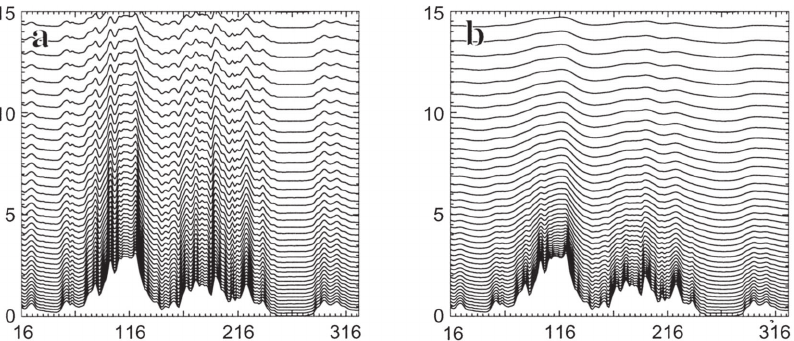
Figure 12. Vertical sections showing terrain-following vertical coordinates using ( a ) standard hybrid coordinates and ( b ) smoothed terrain-following coordinates. From Schär et al. [167]. c (cid:13) Copyright 2002 American Meteorological